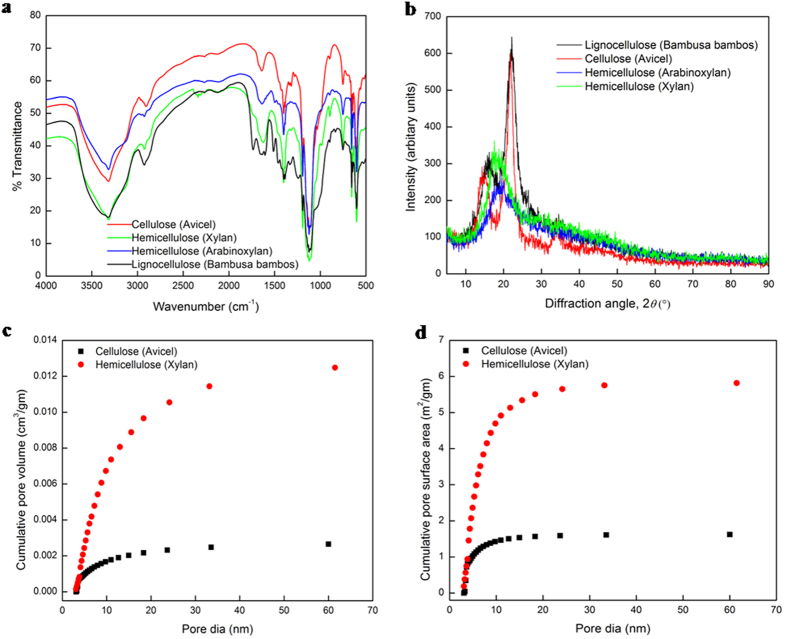
Characterization of cellulosic (Avicel), hemicellulosic (Xylan, Arabinoxylan) and lignocellulosic (Bambusa bambos) substrates.(a) FTIR spectra. (b) XRD patterns. (c,d) Pore size distribution derived from the desorption branch by the Barrett-Joyer-Halenda (BJH) method for cellulose and hemicellulose substrates with porosities of 0.42 and 5.73%, respectively.